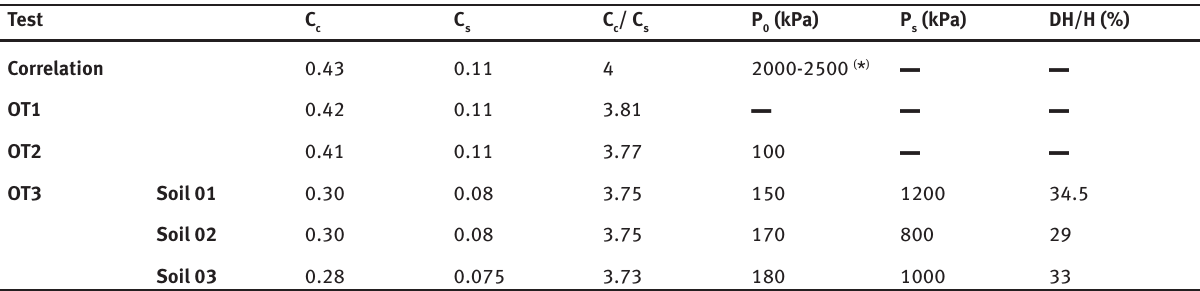
Table 5: Compressibility parameters of oedometric tests.